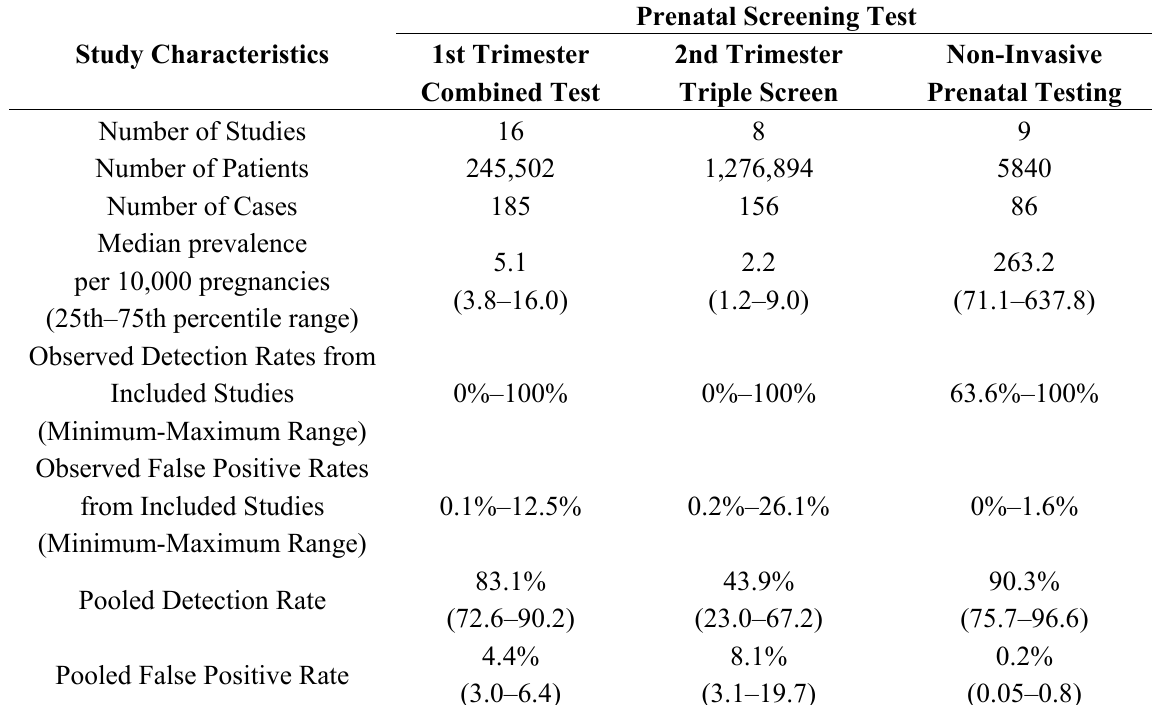
Table 2. Pooled results for trisomy